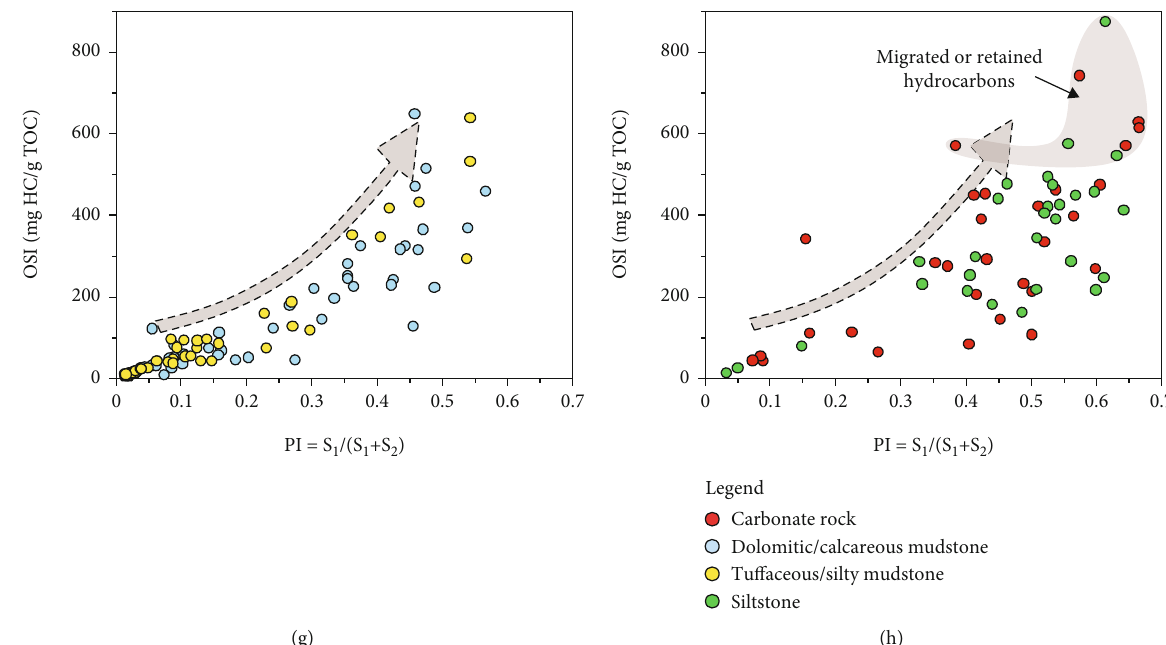
Figure 10: Plots of shale oil potential and hydrocarbon generation potential for di ff erent lithofacies in the Lucaogou Formation, Jimusar